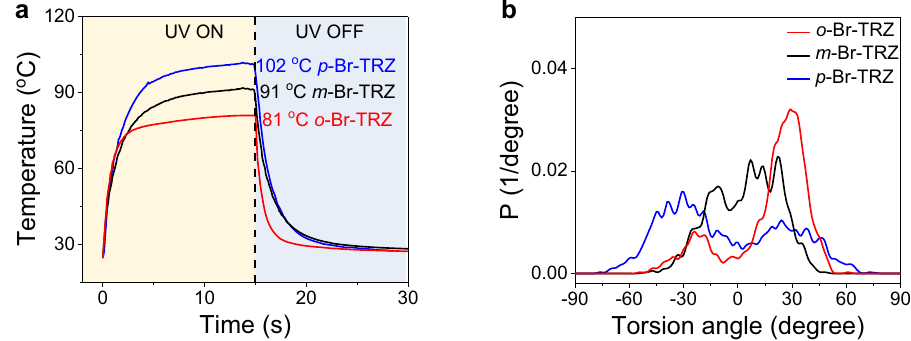
Fig. 3 Photothermal effects of triazine derivatives. a Bromine position-dependent photothermal temperature changes indicate that the photothermal effect is strongly correlated with substituent (Br) position and that p -Br-TRZ is best for photothermal conversion. Note: with irradiation at 365 nm (516 mW/cm 2 ), peak temperatures of the sample (5 mg, diameter of a round cake = 5 mm) were reached within 15 s. b Statistical probability of dynamic torsion angles between two benzene rings for p -Br-TRZ, m -Br-TRZ, and o